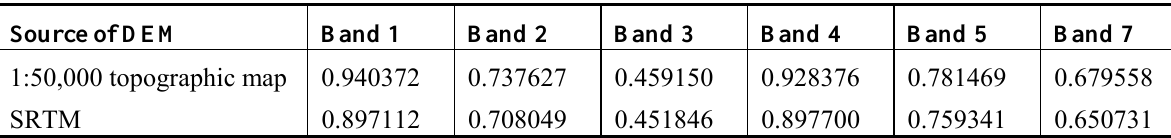
Table 2. Values of k parameter for Minnaert correction based on different spatial resolution